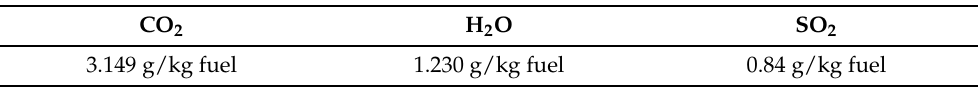
Table 1. Emission indices estimates for CO 2 , H 2 O and SO 2 , averaged from a range of existing studies testing various aviation fuel types. Data derived from